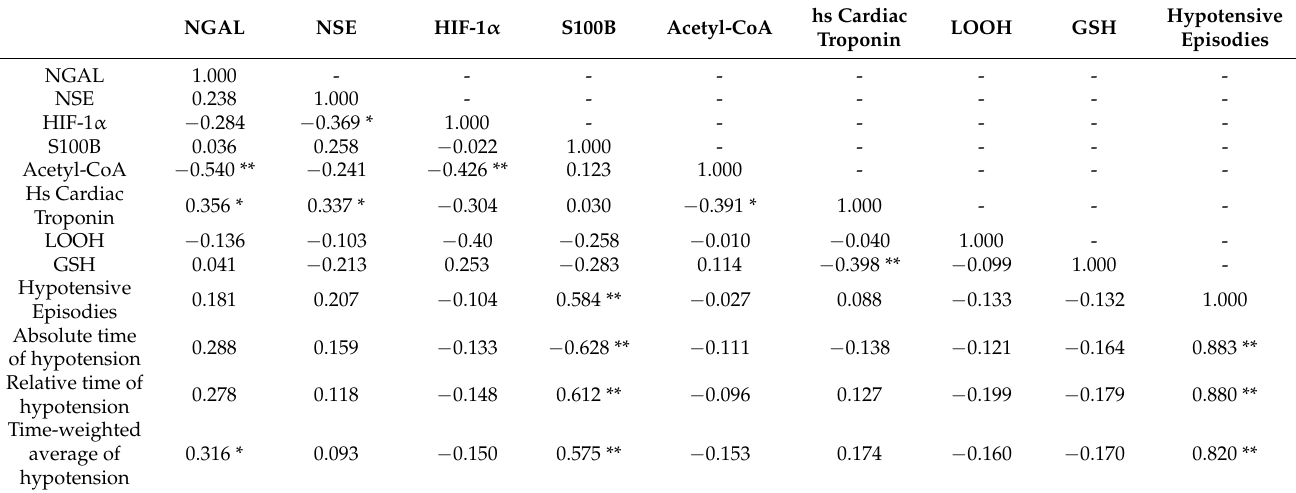
Table 3. Correlation between biochemical markers of inflammation and hypotension-related outcomes.